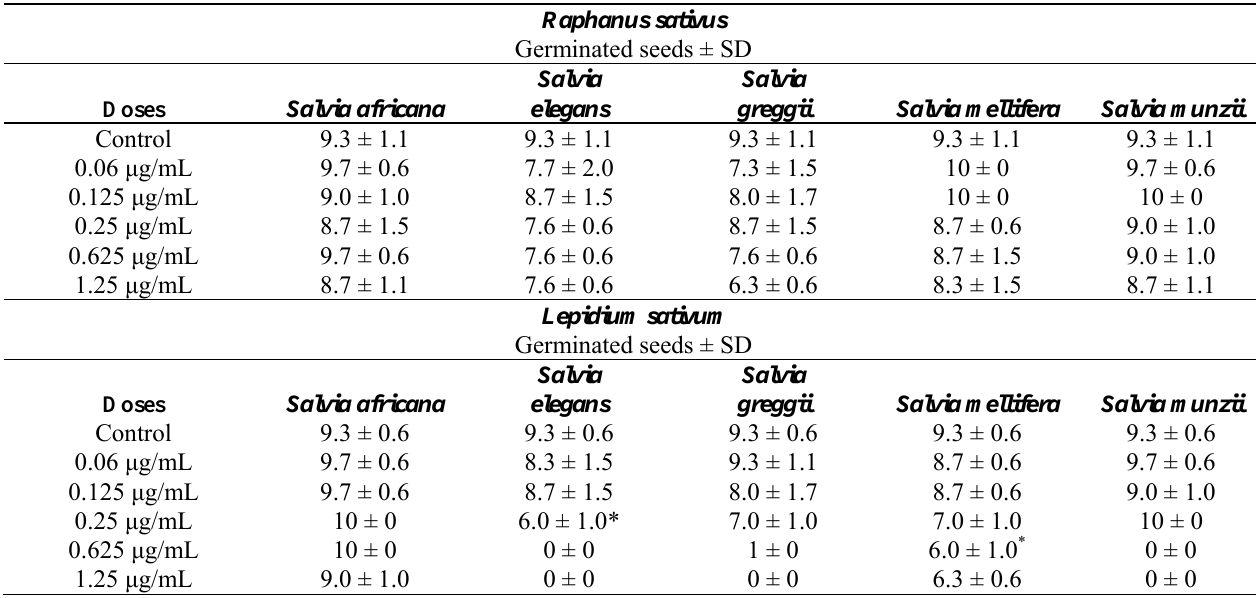
Table 2. Biological activity of essential oils of Salvia africana, Salvia elegans, Salvia greggii , Salvia mellifera and Salvia munzii , against germination of Raphanus sativus and Lepidium sativum , 120 h after sowing. Results are the mean of three experiments ± SD.